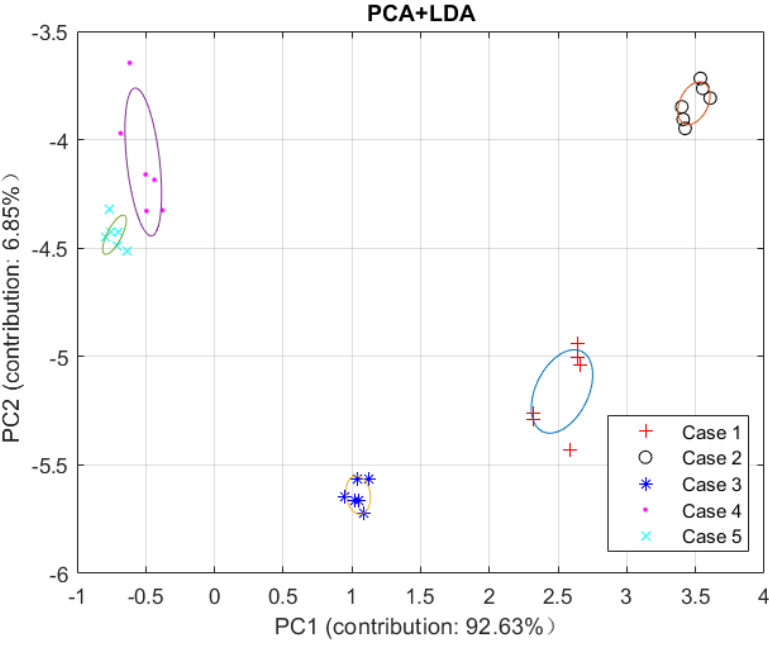
Figure 8. Classification of the five cases.